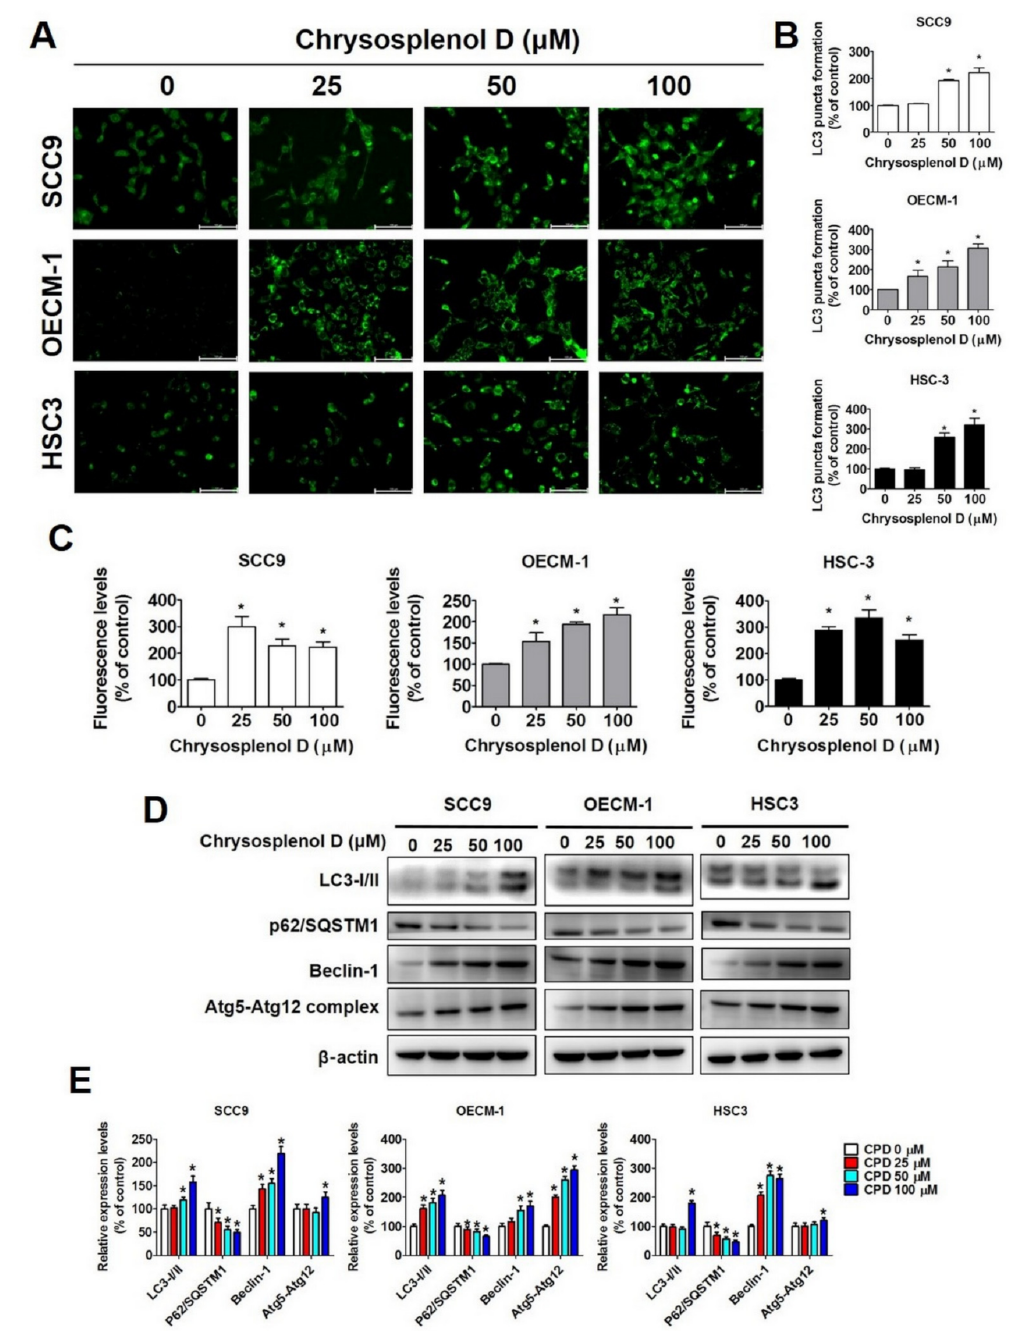
Figure 6. Autophagy induction by chrysosplenol D in OSCC cell lines. ( A , B ) SCC-9, OECM-1, and HSC-3 cells were treated with chrysosplenol D for 24 h, followed by immunostaining and the observation of LC-3 under a fluorescence microscope at a magnification of 200 × . Graphs show the findings of the statistical analysis of LC-3 formation. ( C ) Chrysosplenol D induced the formation of autophagosomes in OSCC cells that was detected using a fluorescence microplate reader at Ex/Em = 485/530 nm. ( D , E ) The protein expression of autophagic markers (LC3-I/II, p62/SQSTM1, Beclin-1, and Atg5–Atg12 complex) was measured through Western blot after chrysosplenol D treatment. The β -actin protein level was used to adjust quantitative results. Graphs show the findings of the statistical analysis of autophagy-related proteins. Data are presented as the mean ± SD from three independent experiments * p < 0.05 compared with the vehicle treatment